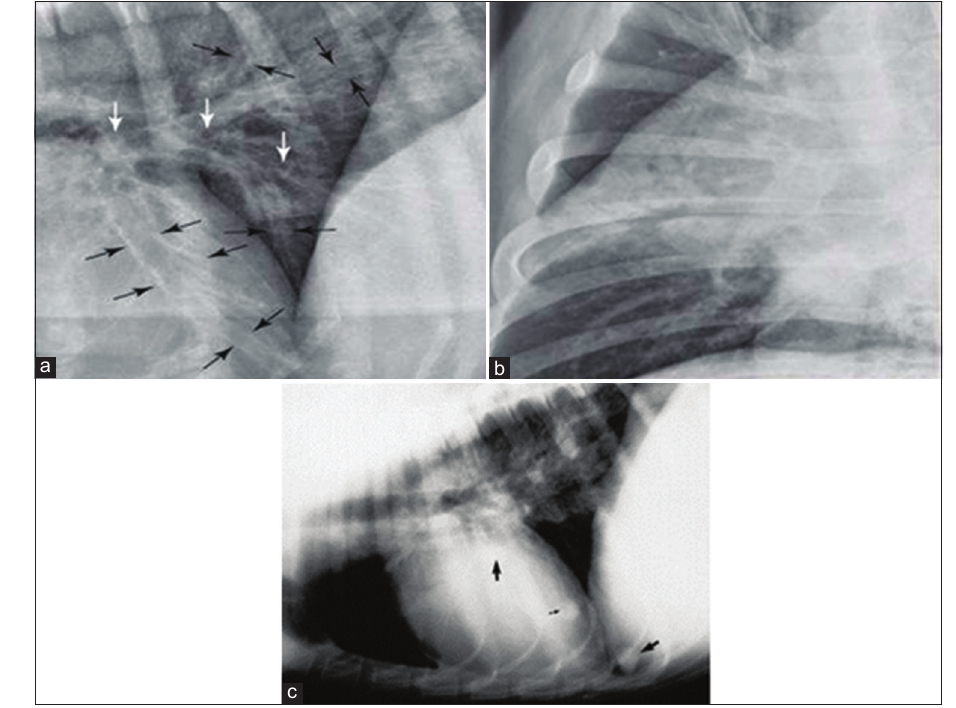
Figure-4: (a) Bronchial pattern [24], (b) lobar sign [24], and (c) cotton-like density